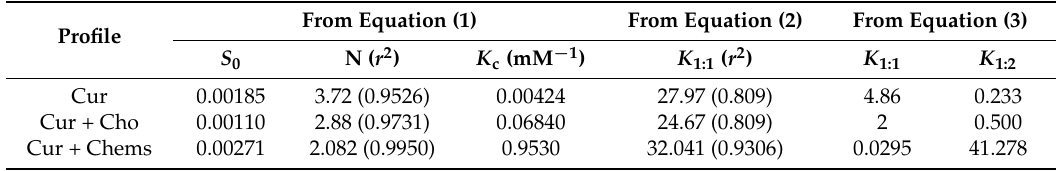
Table 3. Parameters derived from the phase solubility diagrams of Cur vs. different HP β CD concentrations. They are obtained from Equations (1)–(3) in the